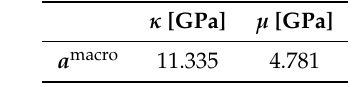
Table 7. Identified optimal value a macro of parameter a = ( κ , µ )